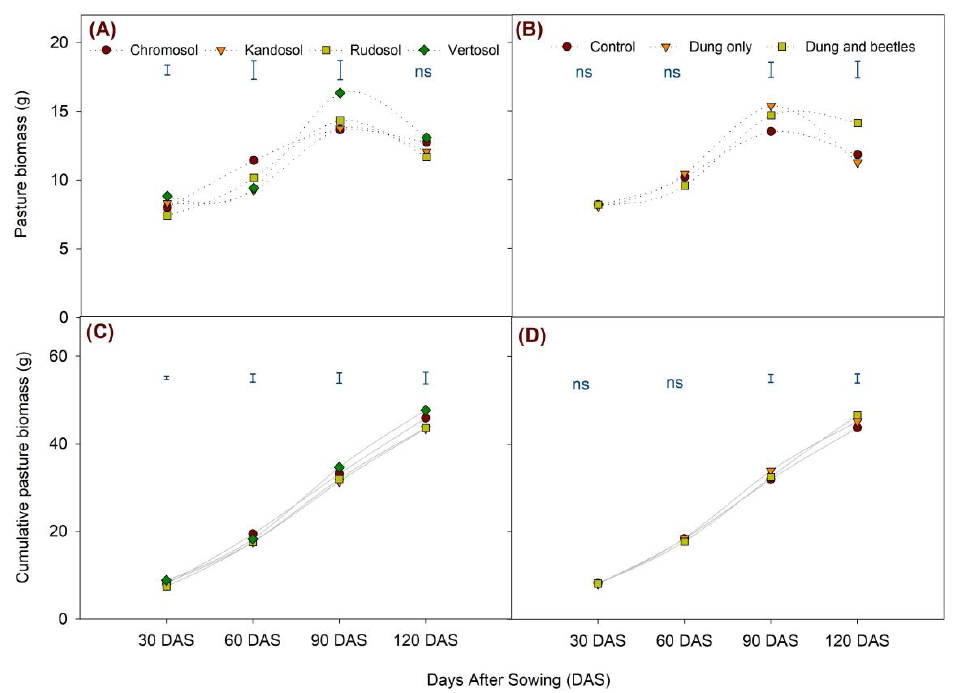
Figure 7. Average pasture biomass at four consecutive harvests, by soil type ( A ) and treatment ( B ). Cumulative pasture biomass at four consecutive harvests by soil type ( C ) and treatment ( D ). Error bars indicate least significant difference at α = 0.05 . ns represents no significant difference.